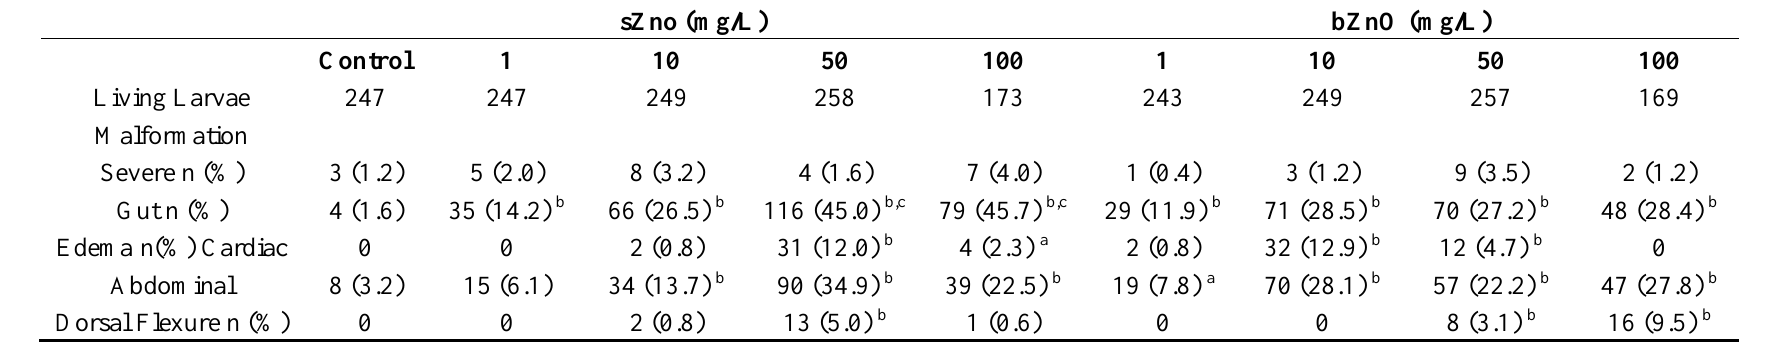
Table 1. Malformation patterns in embryos exposed to sZnO and